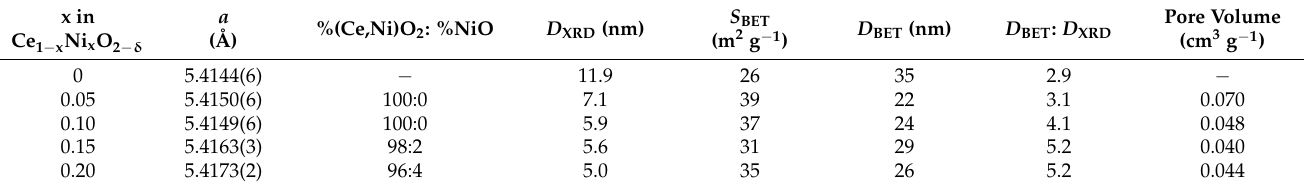
Table 1. Lattice parameter ( a ), phase composition, average crystallite size ( D XRD ), specific surface area ( S BET ), derived equivalent spherical diameter ( D BET ), and pore volume of the Ce 1 − x Ni x O 2 − δ powders